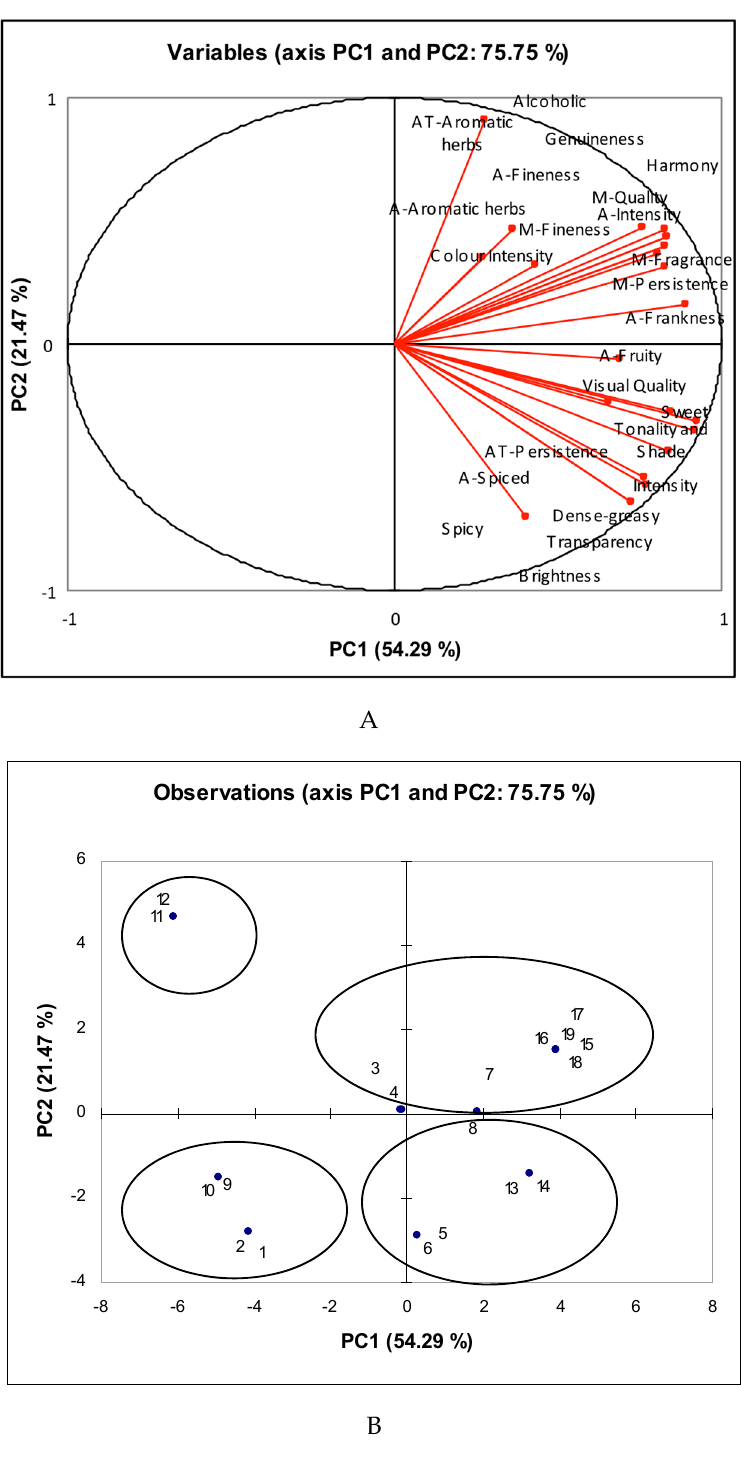
Figure 3. Principal component analysis score plot of ( A ) sensory descriptors and ( B ) samples (19 herbal spirits); A: aroma; AT: aftertaste; M: Mouth.